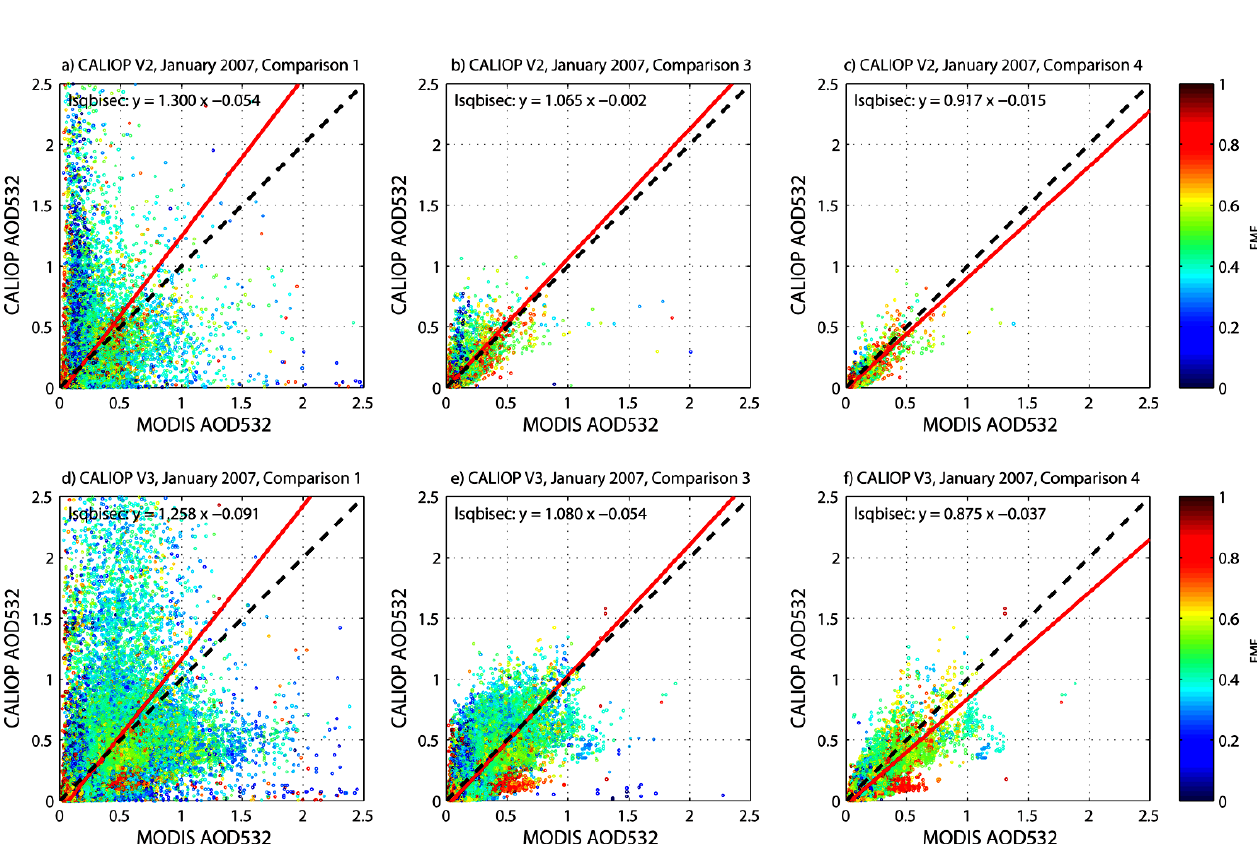
Fig. 3. (a) Comparison of all instantaneously collocated MODIS AOD retrievals for January of 2007 to AOD calculated from CALIOP V2 aerosol extinction profiles. (b) same as (a) , but comparison screened with the methodology summarized as comparison #3 in Table 1. (c) same as a), but comparison screened with the methodology summarized as comparison #4 in Table 1. (d) , (e) and (f) are the same as (a) , (b) and (c) , respectively, but for CALIOP V3. Symbol color represents the MODIS derived fine mode fraction (FMF), i.e., the fraction of AOD that is due to the fine particle mode in the bi-modal fine-coarse mode